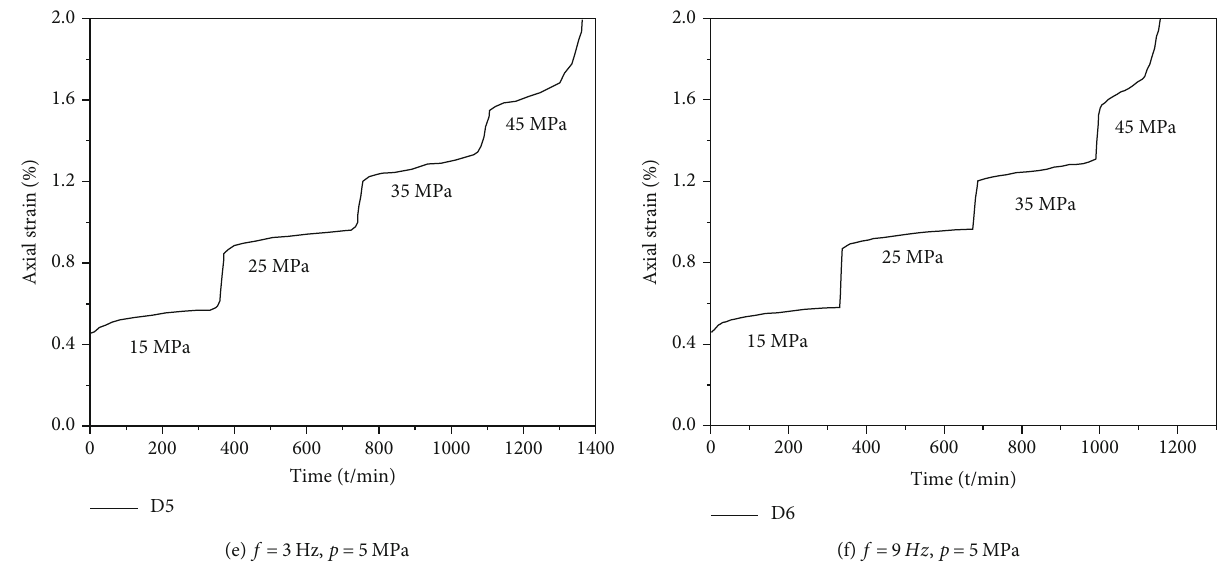
Figure 3: Rock disturbance creep